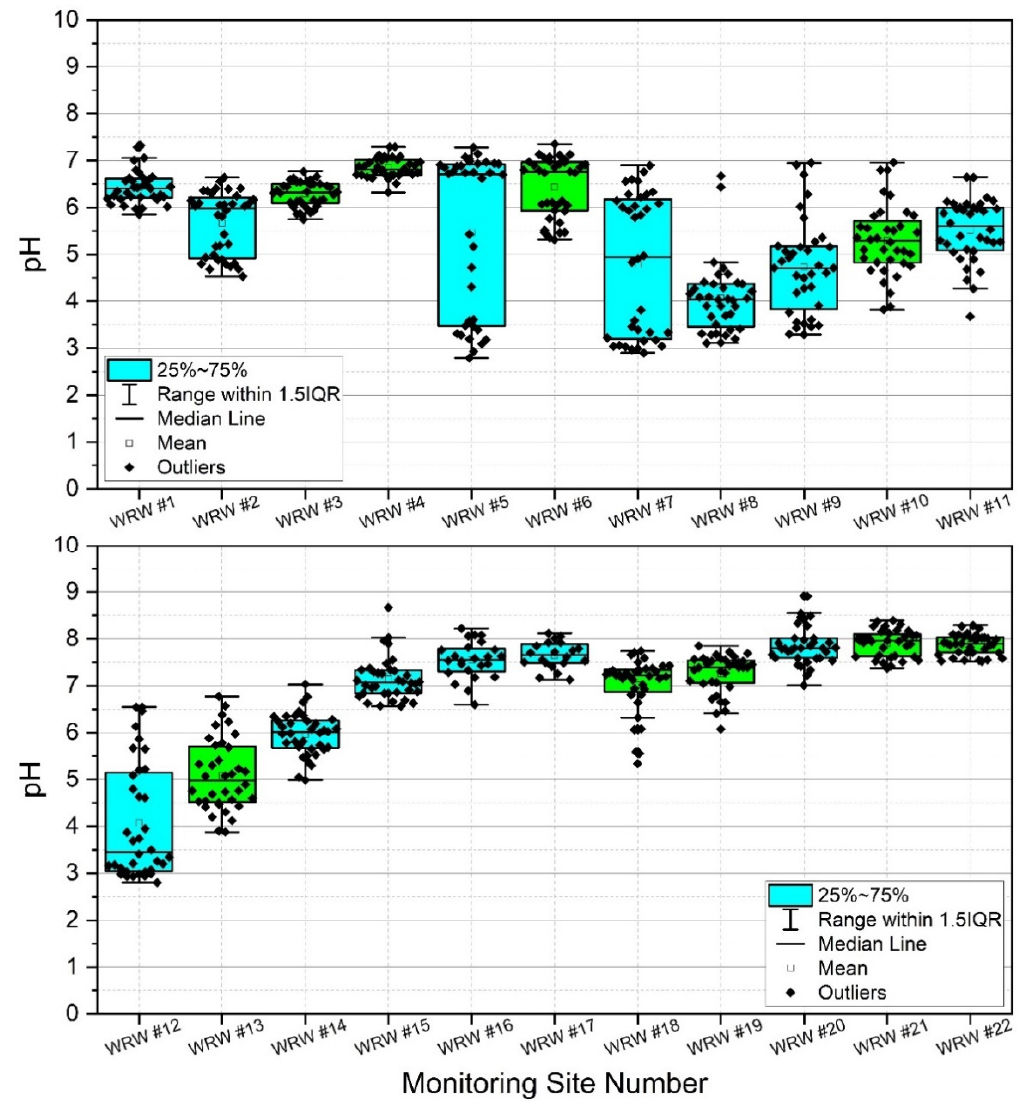
Figure 4. Box and whisker plots reflecting pH sampled weekly at 22 stream monitoring sites during the study period (3 March–3 November 2020) in West Run Watershed, Morgantown, WV, USA. Blue shaded boxes denote tributaries. Green shading denotes main stem West Run Creek.